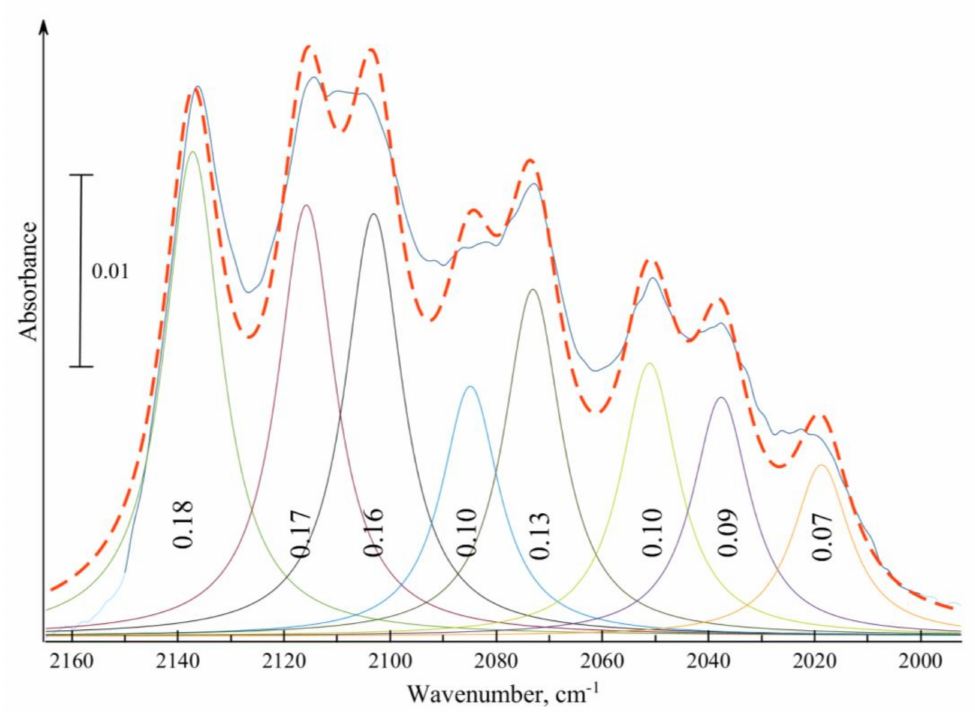
Figure 2. Deconvolution of the band of the ν 1+3 combination mode of the isotopic mixture of ozone (43% of 18 O) chemisorbed on TiO 2 (solid curve). The band is represented by a sum of 8 Gaussians (dashed line). Figures inside of each Gaussian indicate the relative area if the total band intensity is taken as